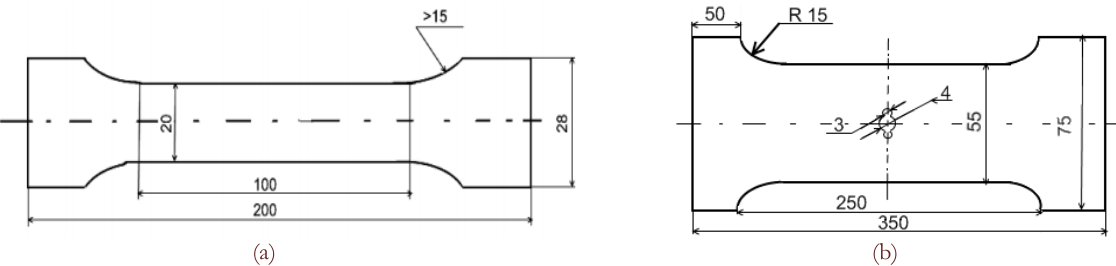
Figure 1: Geometry of specimen (a – smooth specimen, b – specimen with a hole). All sizes are in millimeters.